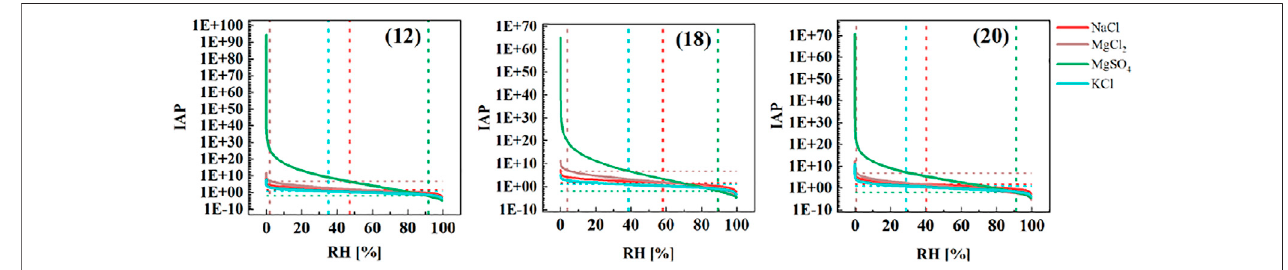
FIGURE 8 | AIOMFAC modeled IAP as a function of RH. The horizontal dashed lines indicate the IAP sat of saturated solutions of four common salts (NaCl, MgCl 2 , MgSO 4 , KCl). The vertical dashed lines are the model predicted DRH for individual salts in the corresponding salt mixtures.